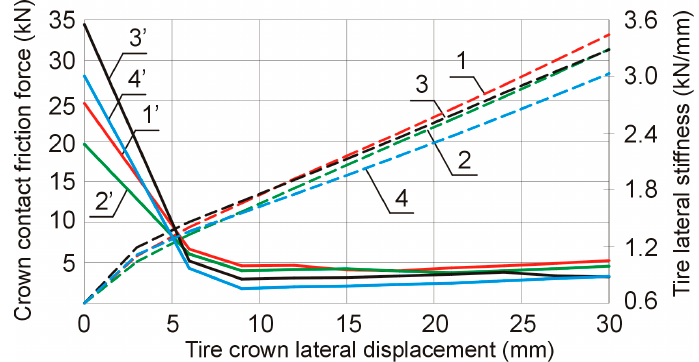
Figure 10. Crown contact friction force and tire apparent lateral stiffness (numbers with ʼ ) for some cord angles on drum θ 0 (rad); 1 – 1.1, 2 – 1.06, 3 – 1.03, 4 – 1.00.